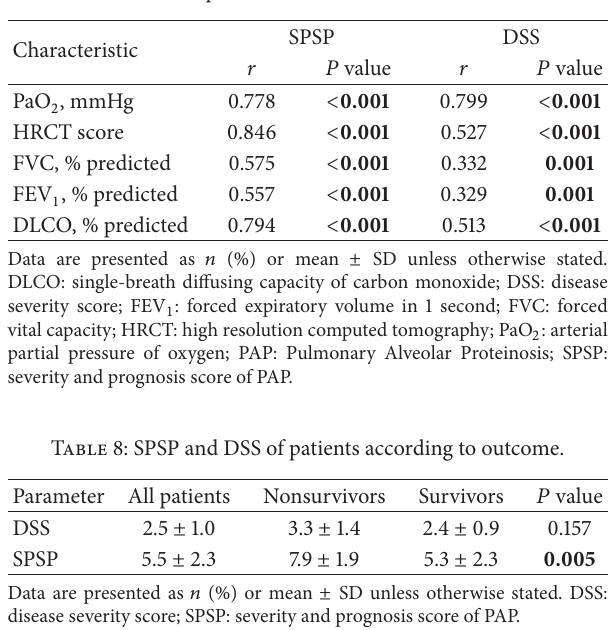
Table 6: Severity and prognosis score of PAP (SPSP). Table 7: Relationships between SPSP or DSS and other indexes.